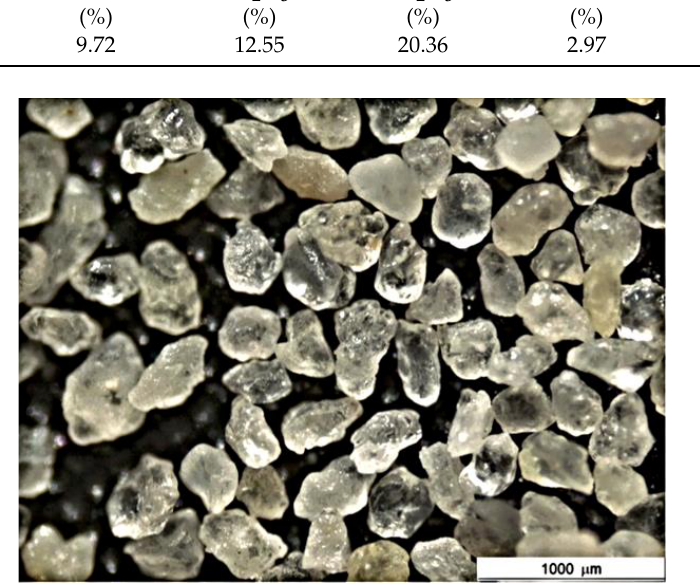
Table 3. Chemical composition of the garnet abrasive [36].